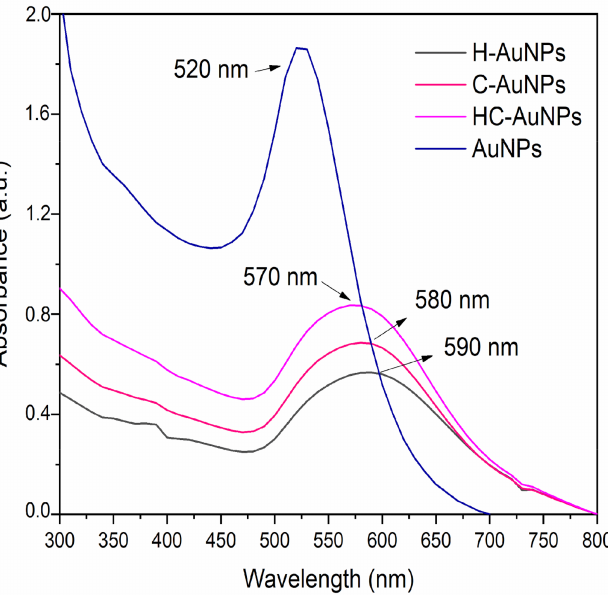
Figure 3. UV-vis spectra of AuNPs before and after the conjugation with HuAL1 and C7H2